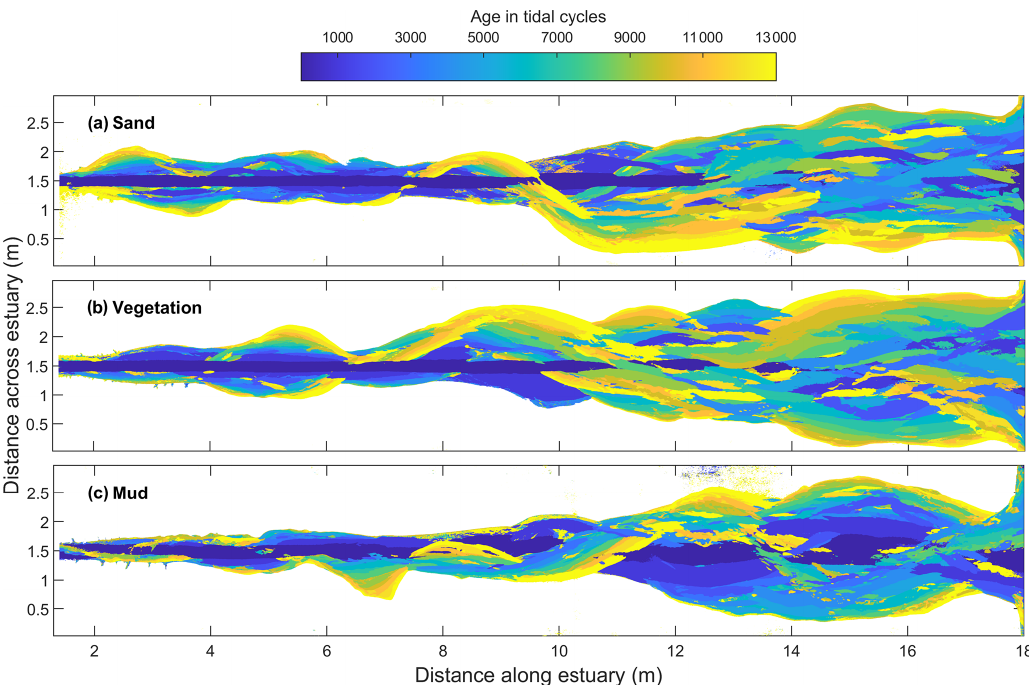
Figure 5. Morphodynamics characterised by the age of the largest depth reached over the duration of the experiments with (a) sand only, (b) vegetation and (c) mud. To avoid overrepresentation by the early stages, only data of every 1000 cycles were